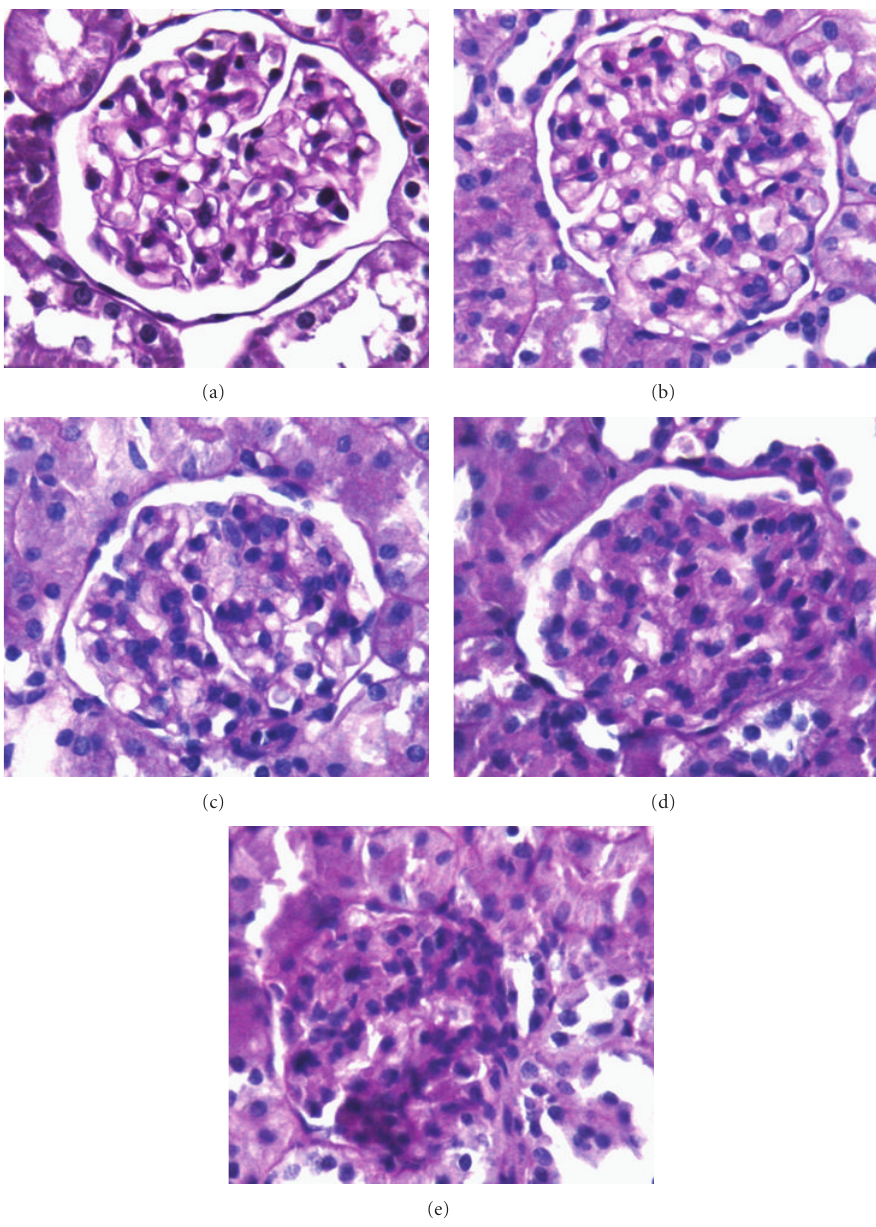
Figure 1: Mesangial matrix expansion (a) PAS × 40, grade 0; (b) PAS × 40, grade +1; (c) PAS × 40, grade +2; (d) PAS × 40, grade +3; (e) PAS × 40, grade